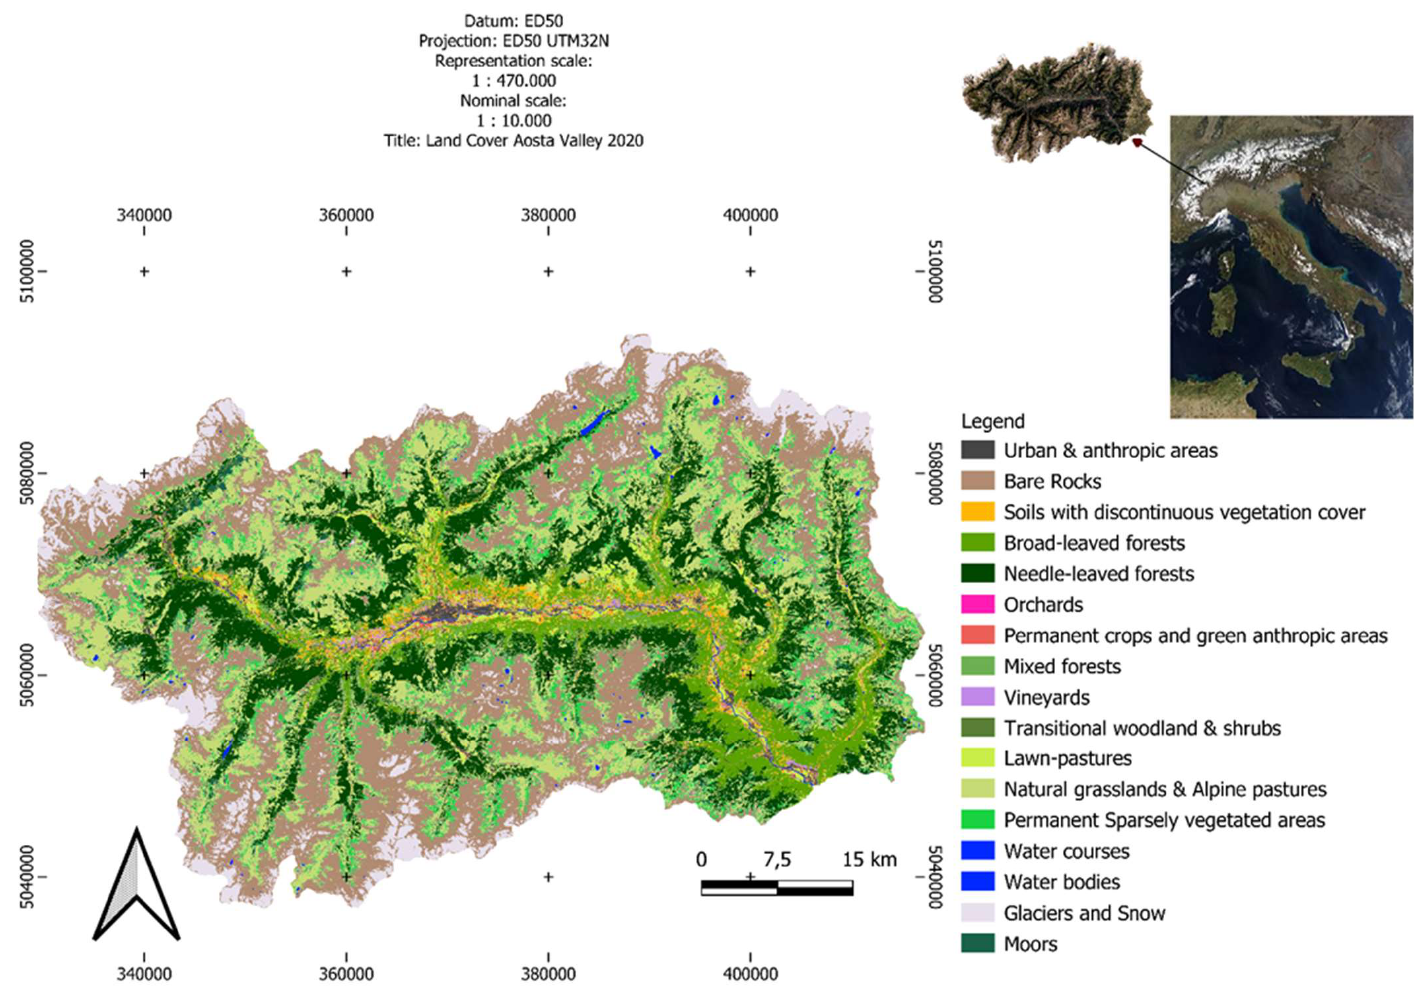
Figure 8. Aosta Valley EAGLE Land Cover according to the methodology proposed.